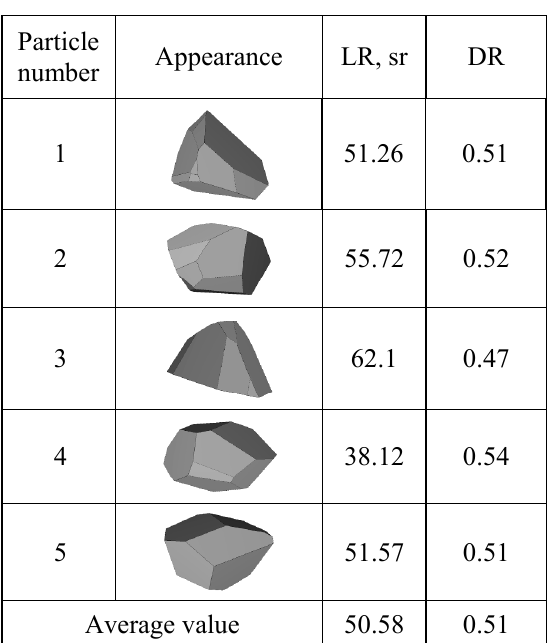
Figure 2. Differential scattering cross section for chosen five ice particles of arbitrary shape Despite the fact that the selected particles differ in the values of their optical characteristics over almost the entire range of scattering angles, in the Figure 3. Differential scattering cross section for vicinity of the backward scattering direction, these the particle of number 5 and the contributions of particles have similar values of the optical some typical non-specular beams (dotted line is characteristics. Therefore, it is sufficient to the contribution of specular reflection, color lines consider in more detail only one particle, for were the contribution of various non-specular example, the particle of number 5. Table 1. Five particles of arbitrary shape, their appearance and optical characteristics in the backscattering direction